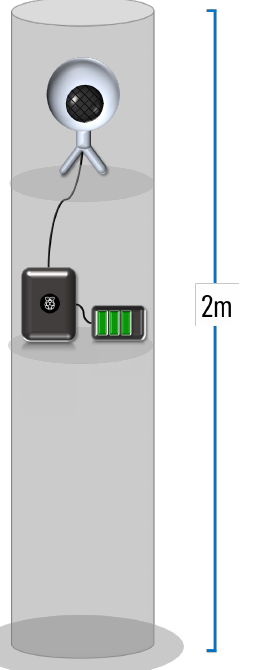
Figure 1. Diagram of the proposed device: Two meter tall structure containing the Raspberry Pi and the microphone slightly tilted